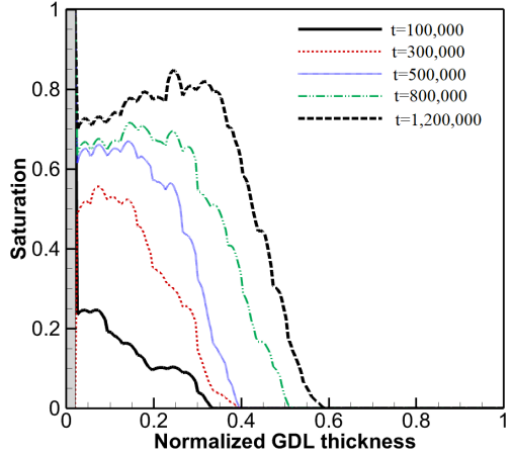
Figure 5. Through-plane liquid water saturation distribution.